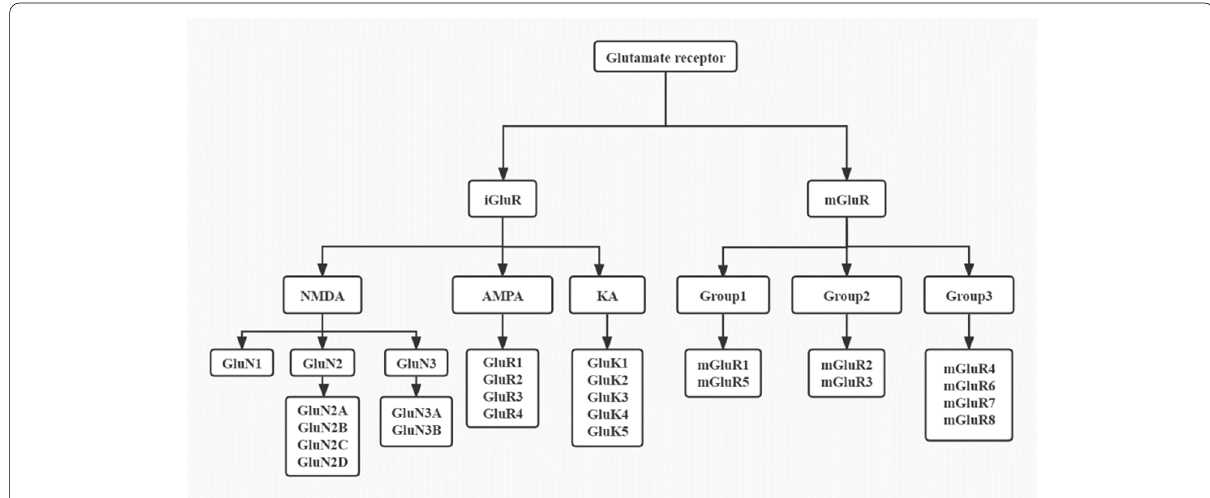
Fig. 7 Classification of glutamate